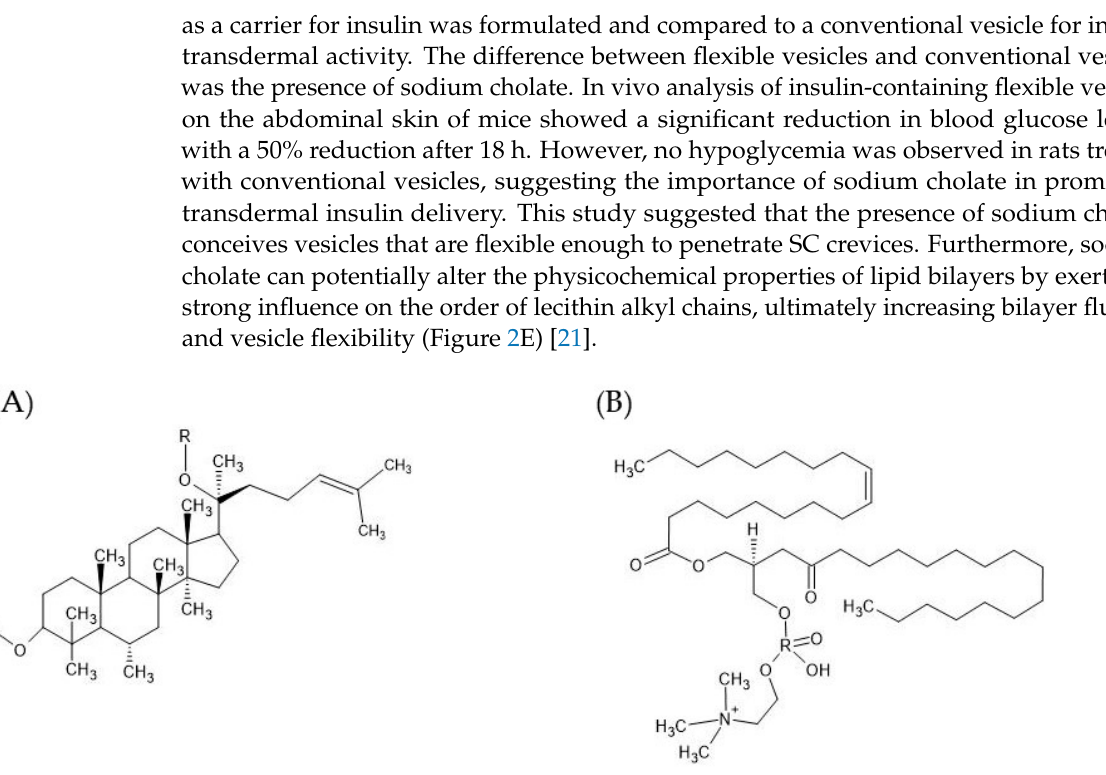
9 of 25 Figure 5. Chemical structure of ( A ) Isopropyl myristate, ( B ) glutaraldehyde, and ( C ) polyvinyl al- cohol. In a recent study, the physiochemical properties of poly [oligo(ethylene glycol) meth- acrylate]-b-poly[(vinyl benzyl trimethylammonium chloride)] (POEGMA-b-PVBTMAC) diblocks and poly[oligo(ethylene glycol) methacrylate-co-(vinyl benzyl trimethylammo- nium chloride)] (P(OEGMA-co-VBTMAC)) copolymers of different composition followed by insulin encapsulation were studied. The addition of the copolymer with insulin has been reported to show good stability and protect proteins from adsorption and aggrega- tion. In addition, electrostatic interactions between oppositely charged polyelectrolytes and biopolymers have been identified, leading to the potential use of these polyelectrolyte systems in the transdermal delivery of insulin [75]. These formulated NPs effectively en- capsulated and delivered insulin across SC membranes and sustained insulin release, thereby prolonging the decline of blood glucose levels. Moreover, the structural integrity of insulin was maintained without degradation throughout the encapsulation process and